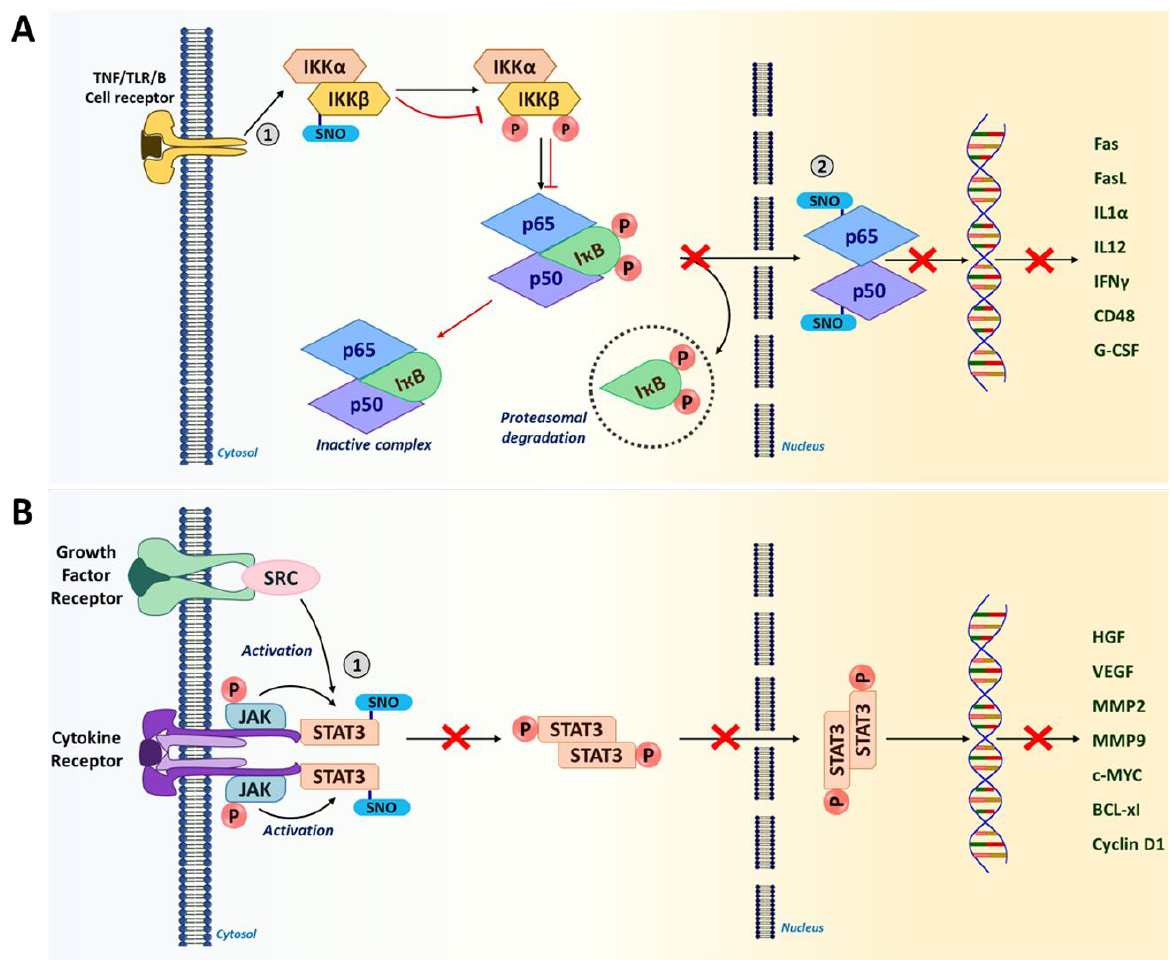
Figure 3. S-nitrosylation in NF- κ B and STAT3 signaling pathways. ( A ) IKK β and NF- κ B subunits (p65 and p50) are S-nitrosylated in the NF- κ B signaling pathway. S-nitrosylation of IKK β at Cys179 prevents the phosphorylation of I κ B and subsequent proteasomal degradation. This results in the inactive NF- κ B-I κ B complex sequestered in the cytosol. Furthermore, S-nitrosylation of NF- κ B subunits p65 (Cys38) and p50 (Cys62) inhibits their DNA binding, in turn, preventing the transcription of NF- κ B target genes including a number of pro-inflammatory cytokines. (Red arrows show the impact of S-nitrosylation.) ( B ) In tumor cells, when STAT3 is phosphorylated, it leads to the expression of genes related to proliferation and angiogenesis that promote tumor progression. However, S-nitrosylation of STAT3 at Cys259 leads to its inactivation by preventing phosphorylation. This could lead to improved immunogenicity in the TME. (1 and 2 represent the site of S-nitrosylation in the pathway).